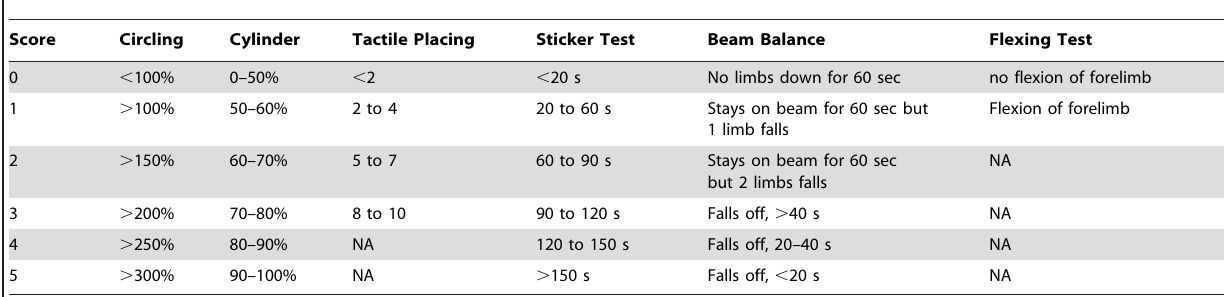
Table 2. Details of different behavioral tests and scores.